Question: What form of chart is displayed?
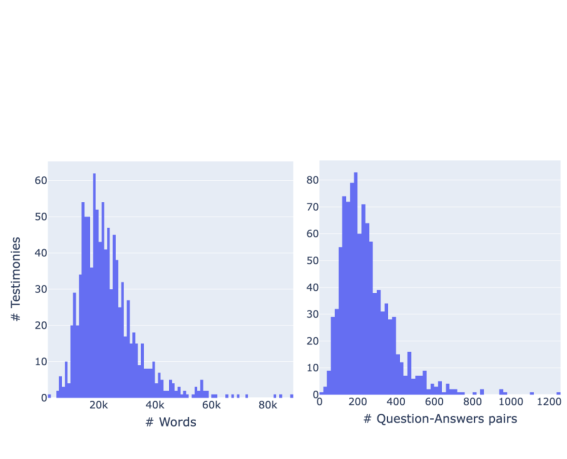
Answer: histogram